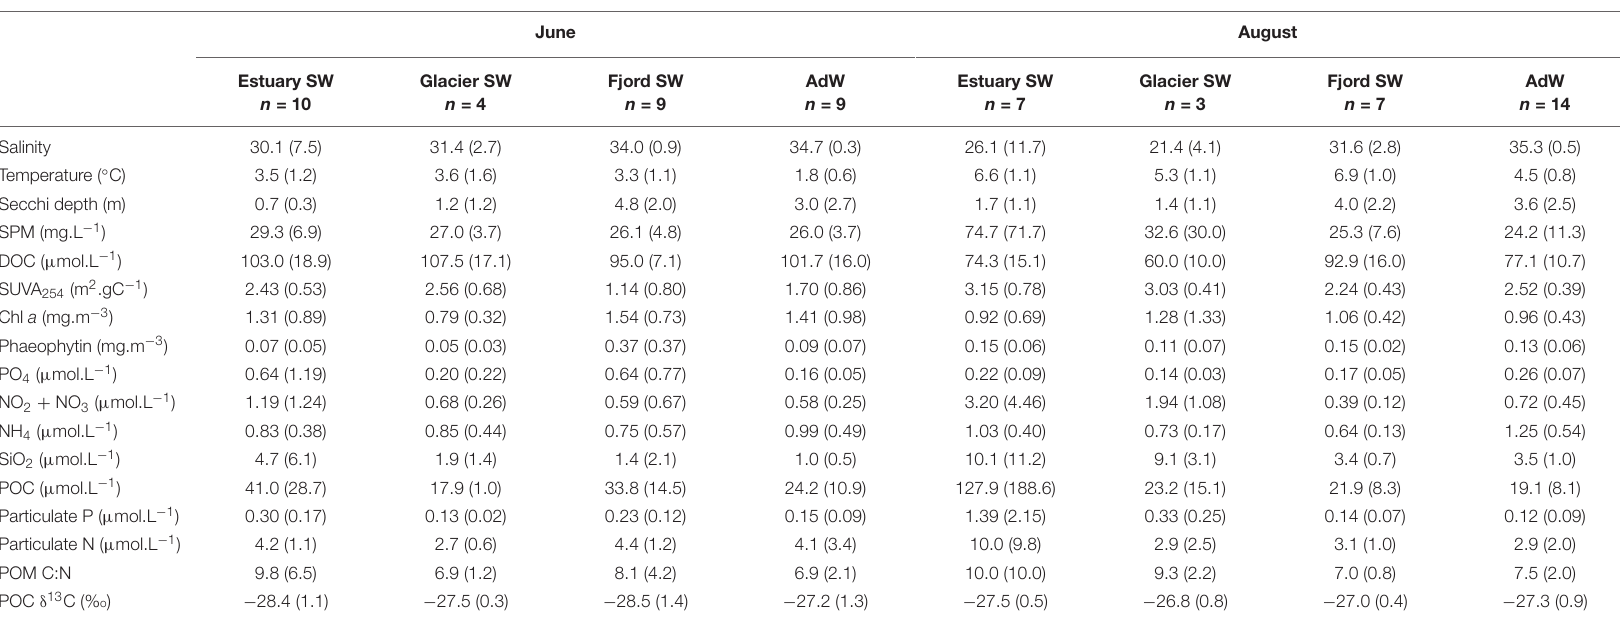
TABLE 1 | Monthly averaged ( ± Standard Deviation) physical and chemical properties in the water column for each water type. Standard deviations are given in parentheses. n gives the number of samples considered in each group for calculations. Retrieved and adapted from McGovern et al.